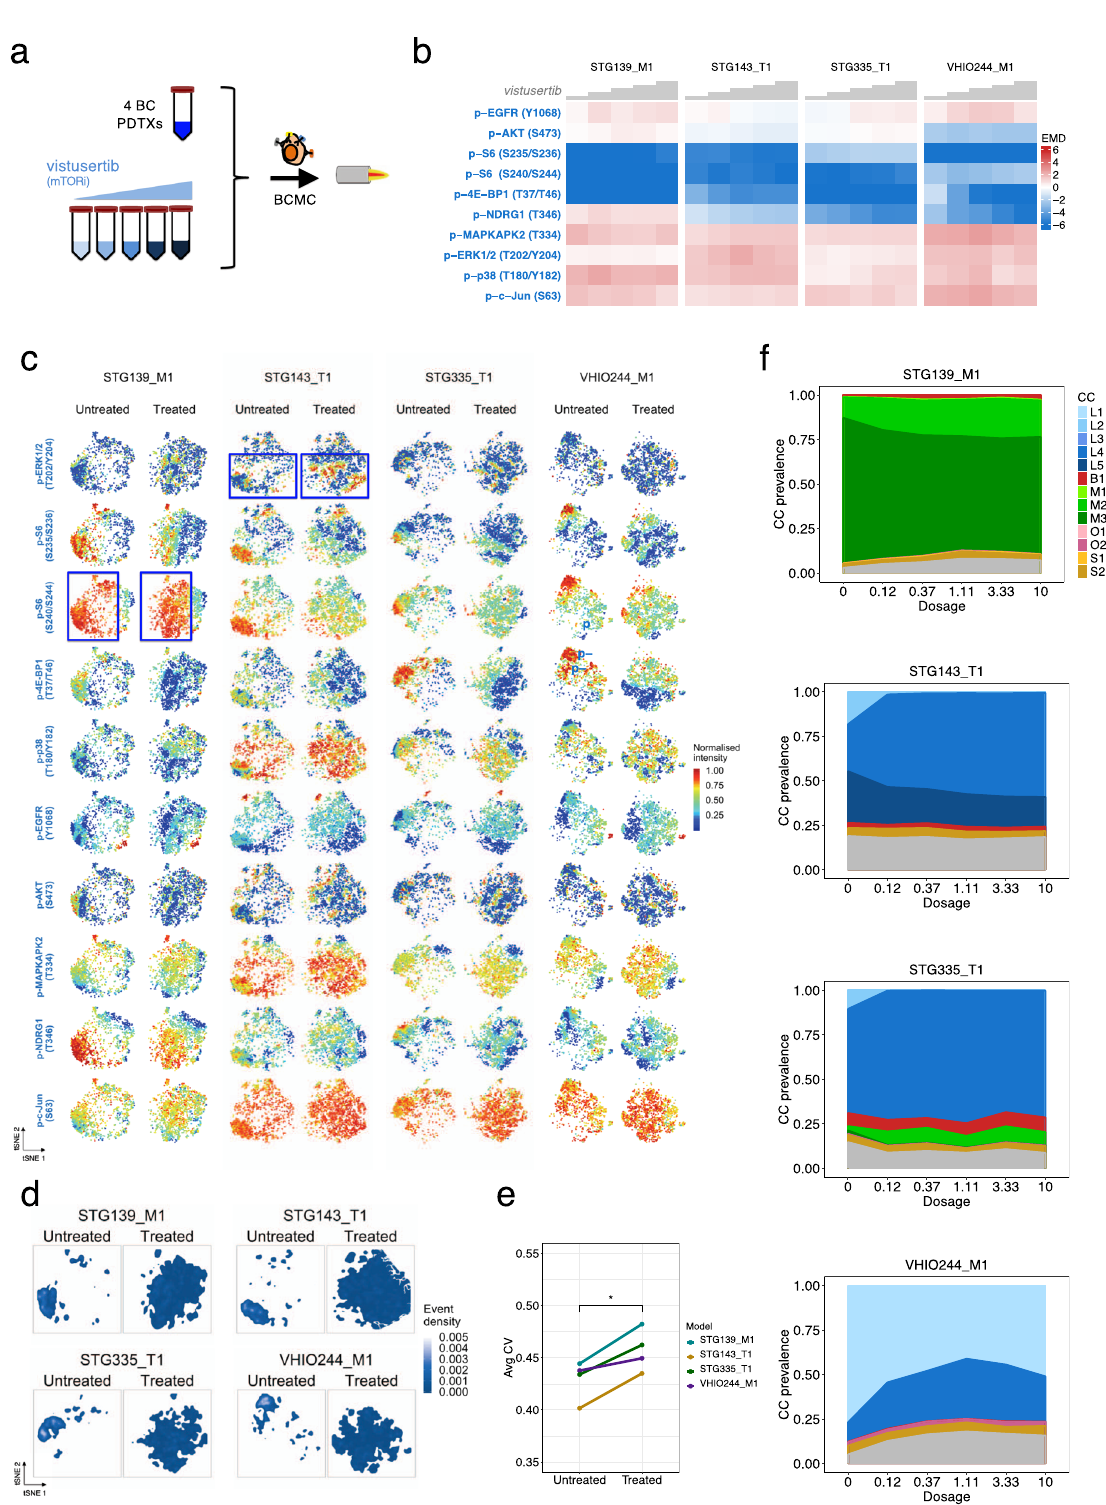
model-speci fi c changes (e.g. p-ERK induction in STG143_T1; lack of p-S6 (S240/S244) inhibition in STG139_M1) (Fig. 6c, indicated in blue squares). mTOR inhibition by vistusertib caused an apparent dispersion of cellular phenotypic states, suggestive of plasticity and phenotypic equilibrium 59 (Fig. 6d). This pheno- typic plasticity correlated with an increase in the average varia- bility of oncogenic signalling activation (Fig. 6e). We applied